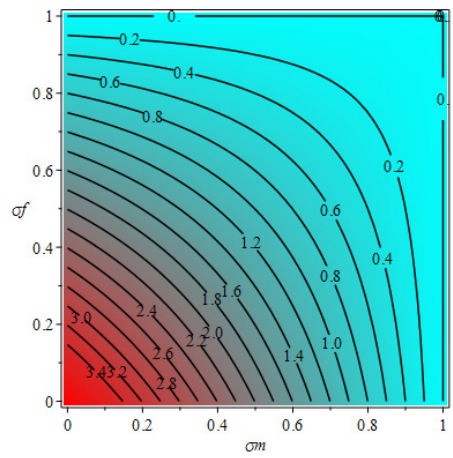
Figure 12. Contour plots of the reproduction number of the model (3), as a function of face mask and mass